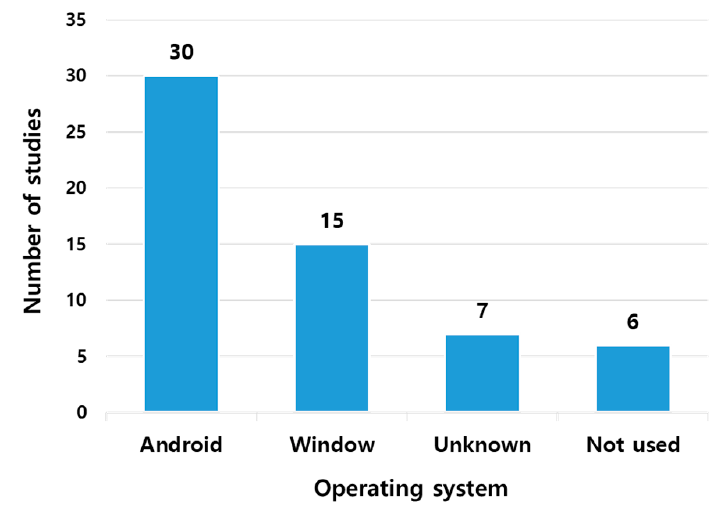
Figure 14. Frequency of use of operating systems. Figure 13. Frequency of use of operating systems.